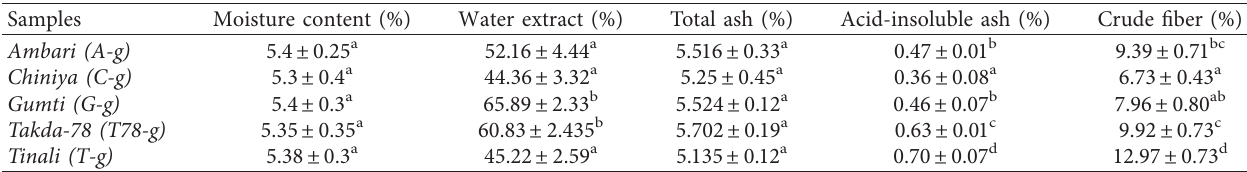
Table 1: Moisture content, water extract, total ash, acid-insoluble ash, and the crude fiber content of green tea prepared from different clones of the tea plant.